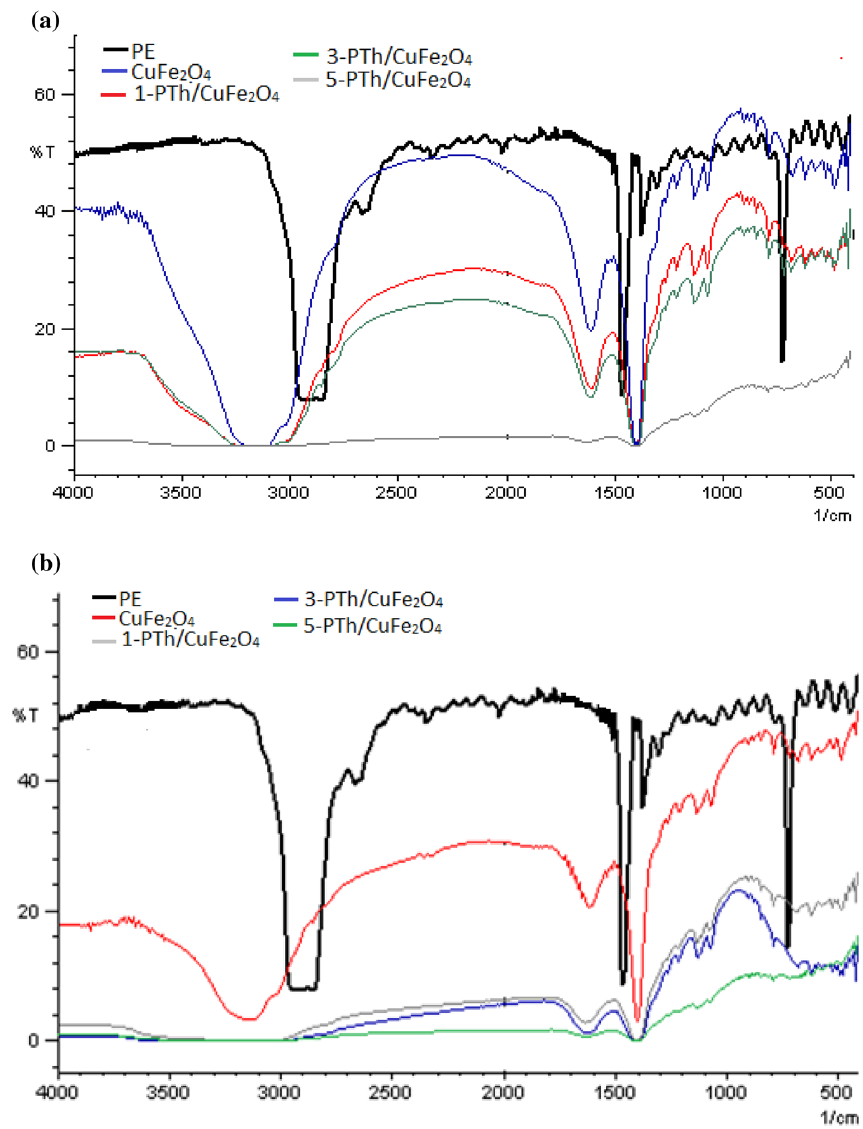
Figure 7. FTIR of ( a ) photo-catalytically degraded PE films ( b ) microwave degraded PE films.